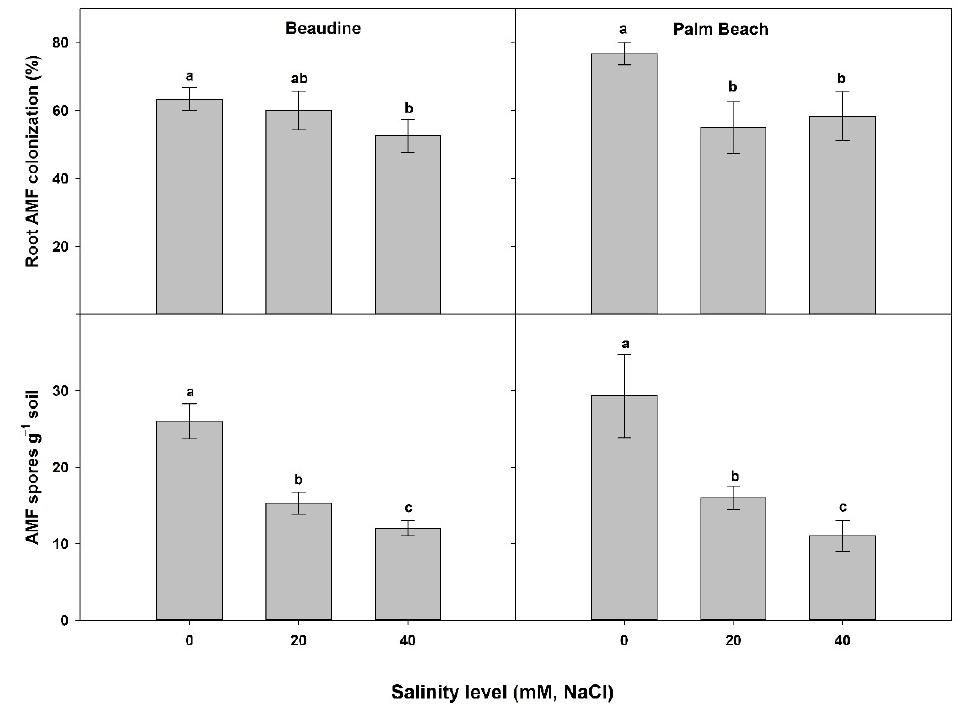
Figure 3. Root AMF colonization and the number of spores for gerbera cultivars (‘Beaudine’ red; ‘Palm Beach’ yellow) inoculated with AMF under different salinity levels at the end of the experiment. No root colonization or soil spores were found in uninoculated gerbera plants. The different letters above the bars indicate significant differences between treatments according to Tukey’s HSD test (p ≤ 0.05).